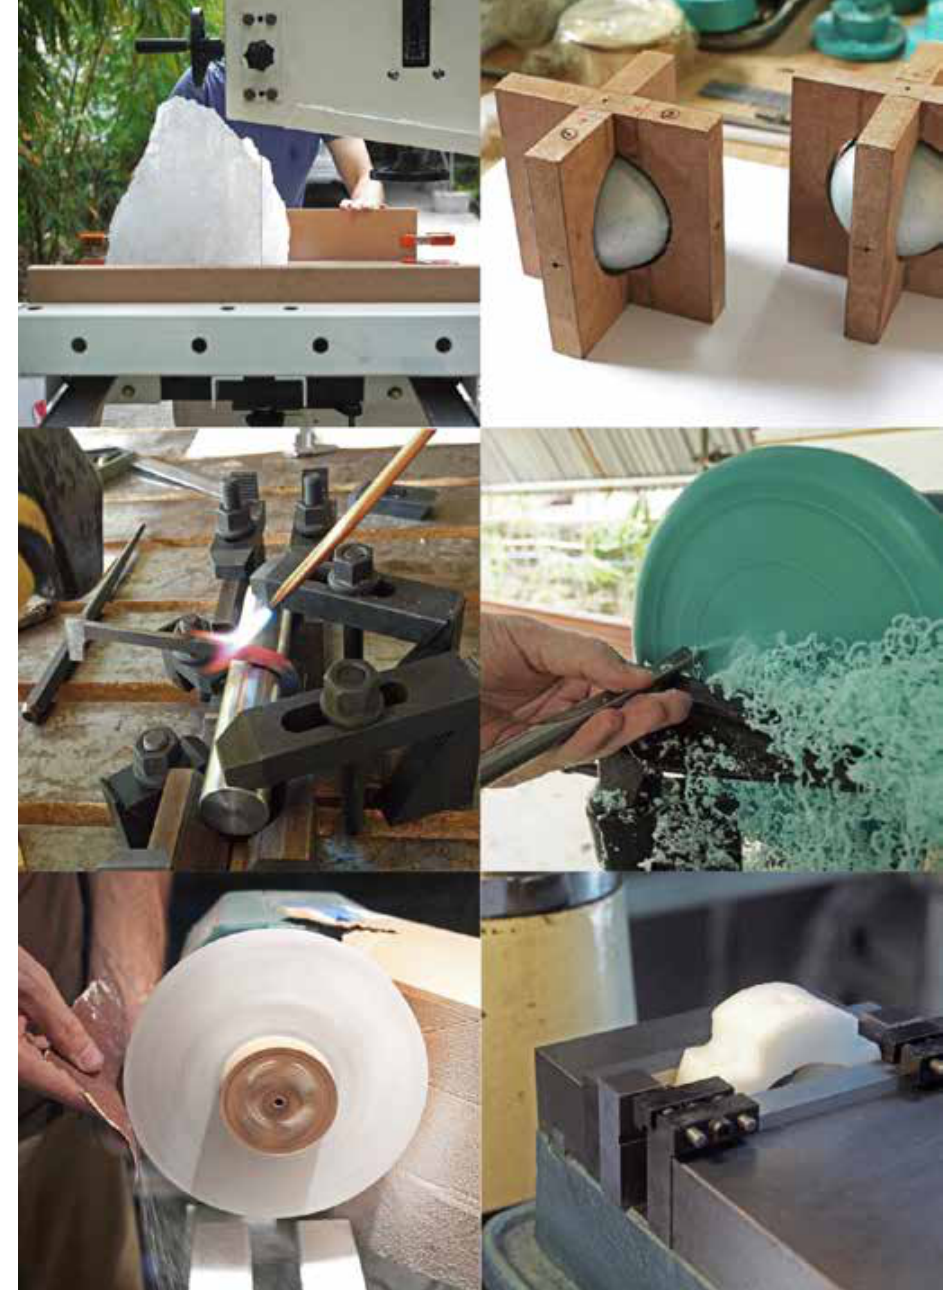
Figure 8: Sharpening tools and working